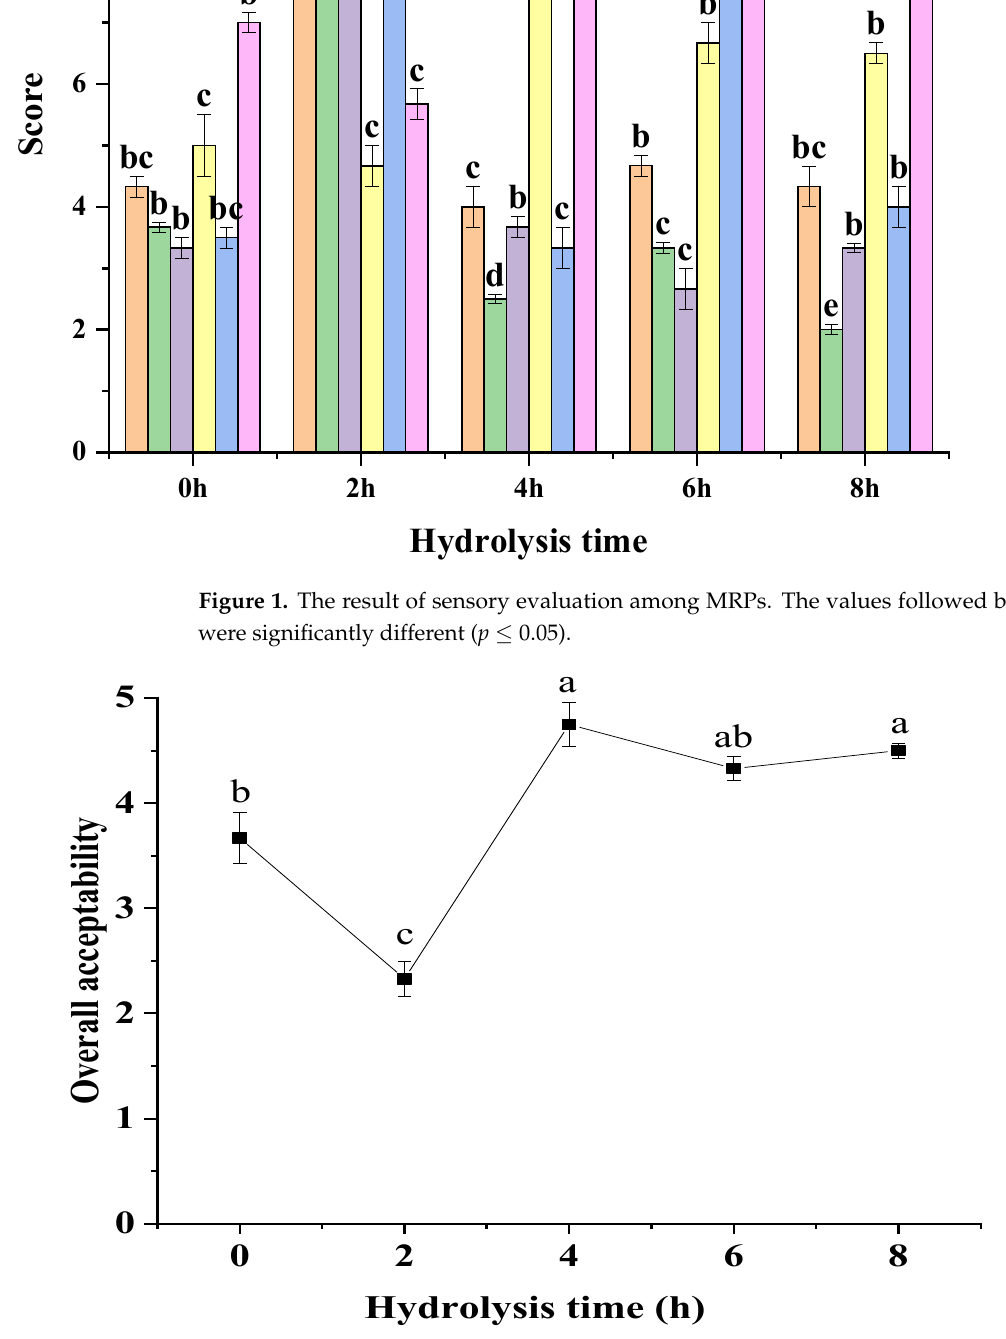
Figure 2. The overall acceptability of MRPs. The values followed by different letters were significantly different ( p ≤ 0.05).